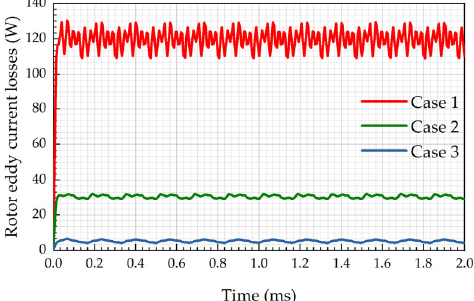
Figure 15. Eddy ‐ current losses in the three cases at rated load.